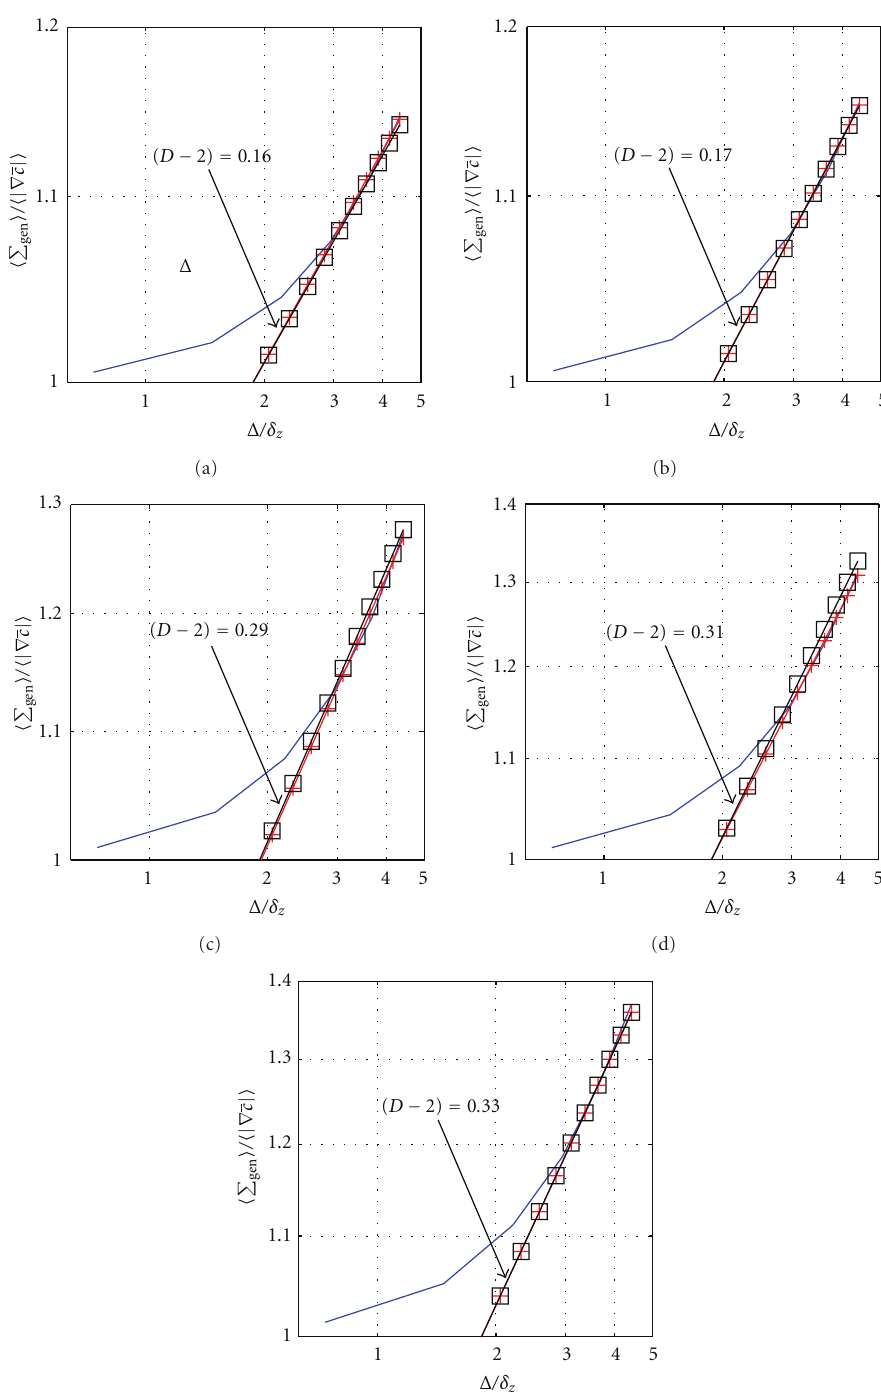
Figure 2: Variation of (cid:5) Σ gen (cid:6) / (cid:5)|∇ c |(cid:6) ( ) with Δ /δ z on a log-log plot for (a–e) cases A–E. The prediction of (cid:5) Σ gen (cid:6) / (cid:5)|∇ c |(cid:6) = ( Δ /η i ) D − 2 ( ) with η i obtained from DNS and D according to (11) ( ) is also